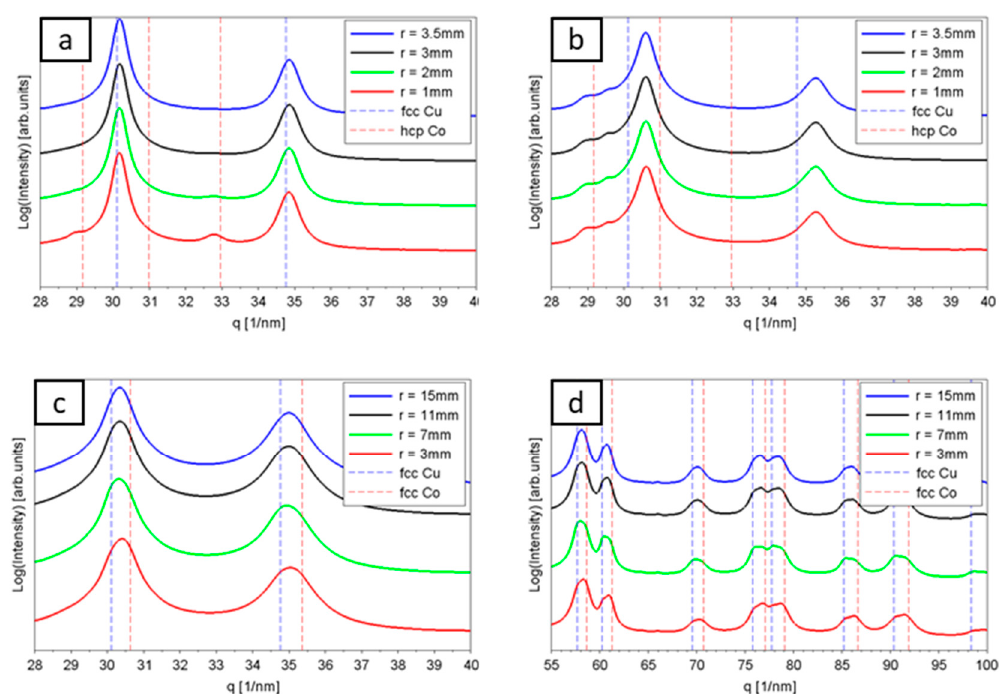
Figure 6. Synchrotron data for three CuCo specimens ( a ) Cu 81 Co 19 deformed at room temperature, ( b ) Cu 22 Co 78 deformed at 300 °C, ( c ) Cu 55 Co 45 deformed at elevated temperature and lower applied strain rate. Note the larger radius of the specimen, ( d ) like ( c ) but showing a different regime of scattering vector q.